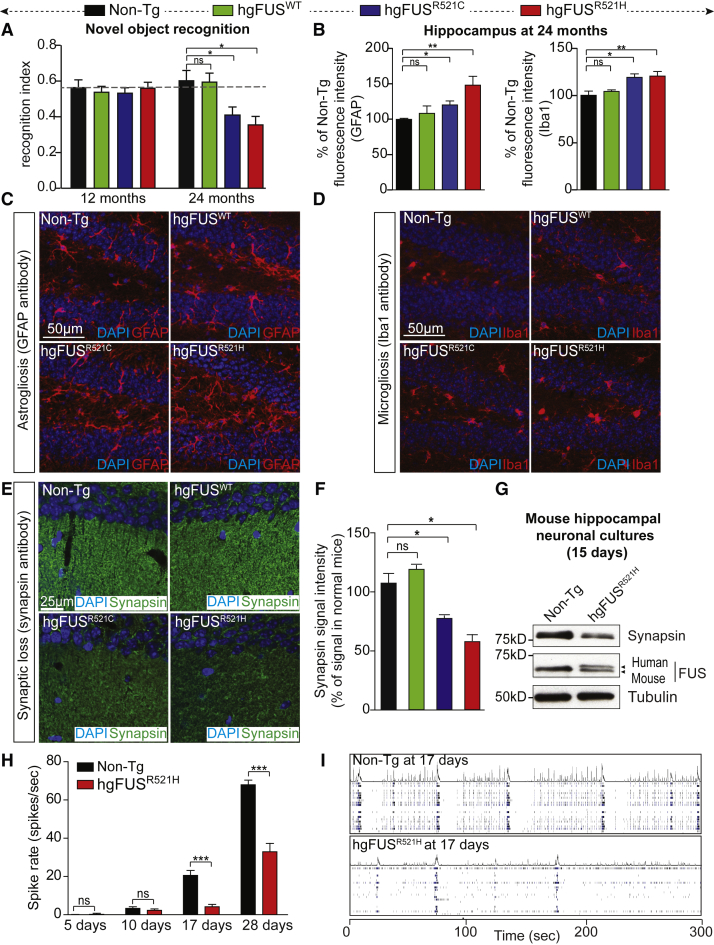
Age-Dependent Progressive Cognitive Impairments, Astrogliosis, and Microgliosis in Hippocampus of Mice Expressing ALS-Linked FUS Mutants(A) Novel object recognition was measured in 12- and 24-month old Non-Tg, hgFUSWT, hgFUSR521C, and hgFUSR521H mice. Data are represented as mean ± SEM (n = 15 per group). ∗p < 0.05 using one-way ANOVA. See also Figure S3.(B) Quantification of the GFAP and Iba1 relative fluorescence intensities in hippocampal sections of 24-month-old Non-Tg, hgFUSWT, hgFUSR521C, and hgFUSR521H mice. The bar graph represents mean ± SEM (n = 3 per group). ∗p < 0.05, ∗∗p < 0.01, two-sided unpaired Student’s t test.(C and D) Hippocampal sections from 24-month-old Non-Tg, hgFUSWT, hgFUSR521C, and hgFUSR521H mice immunostained using an antibody detecting activated (C) astrocytes (GFAP) or (D) microglia (Iba1). DNA is stained with DAPI. Scale bar, 50 μm.(E) Hippocampus from 24-month-old Non-Tg, hgFUSWT, hgFUSR521C, and hgFUSR521H mice immunostained to reveal synapses (green) using a synapsin antibody and DAPI for nuclei. Scale bar, 25 μm.(F) Quantification of the synapsin relative fluorescence intensity shown in (E). The bar graph represents mean ± SEM (n = 3 per group). ∗p < 0.05, two-sided unpaired Student’s t test.(G) Synapsin and FUS protein levels in hippocampal neuronal extracts from mutant hgFUSR521H or Non-Tg mice (at 15 days of culture). Tubulin antibody was used as loading control.(H) Spontaneous neuronal spike rate (spikes per s) measured by multi-electrode arrays (MEA) in hippocampal neurons from mutant hgFUSR521H compared to Non-Tg mice cultured under basal conditions. Data are represented as mean ± SEM (n = 4–8 numbers of wells per experiment from three independent experiments). ∗∗∗p < 0.001, two-sided unpaired Student’s t test.(I) Raster plots from MEA recordings showing neuronal spikes and burst of spikes in wild-type and mutant hgFUSR521H hippocampal neurons for 300 s. Each lane represents spikes per s recorded per electrode.